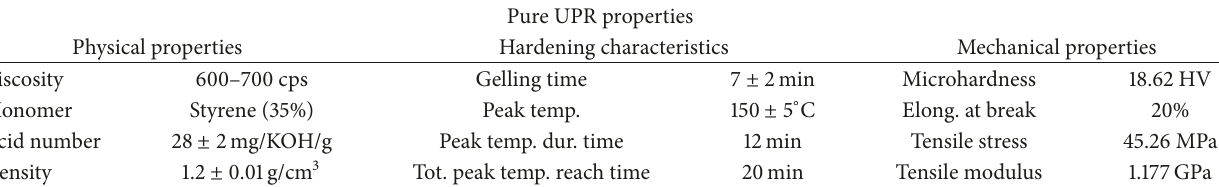
Table 1: Properties of UPR given by the manufacturer.